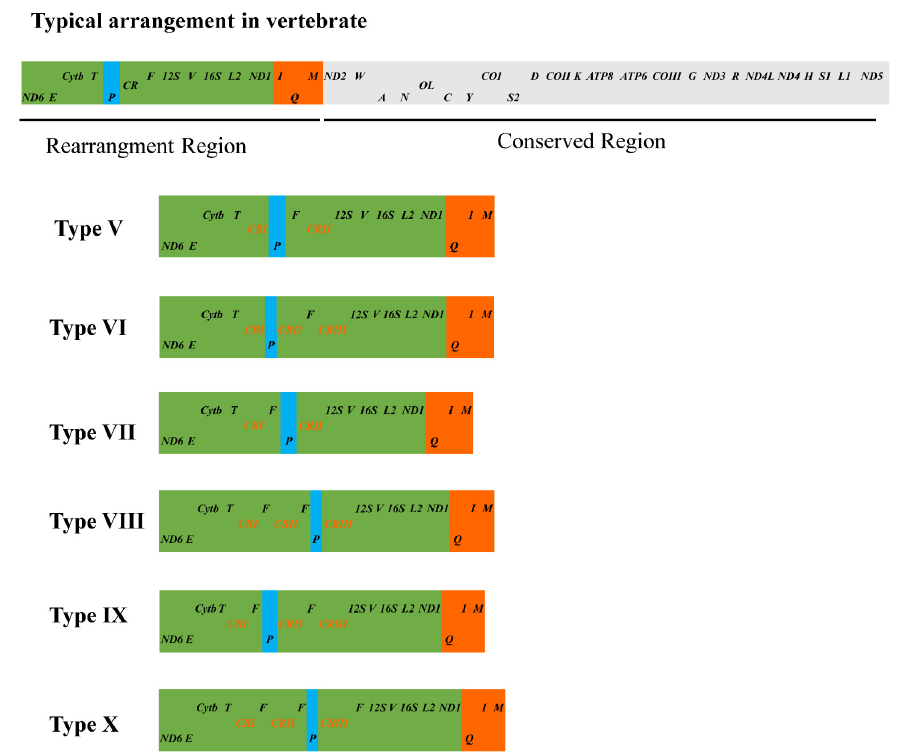
Figure 5. Type of the gene arrangements of the Phrynocephalus spp. mitogenomes. Genes encoded by the heavy and light strands are denoted at the top and bottom of each gene rectangle box, respectively. The sizes of the boxes do not reflect the actual gene length. OL, light strand replication origin. CR, control region (D-loop). Assignment of the rearrangement type number corresponds to that in Liu et al. [18].